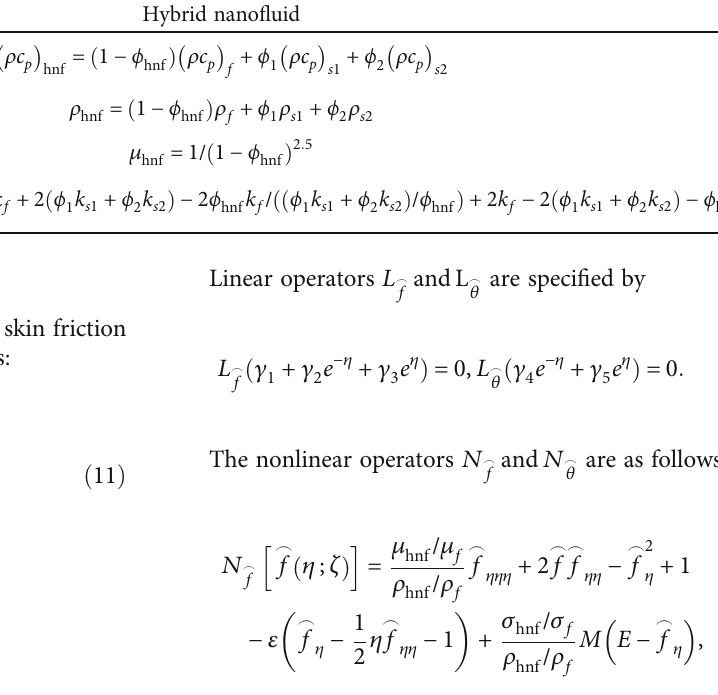
Table 1: Illustration of thermo-physical properties of Al